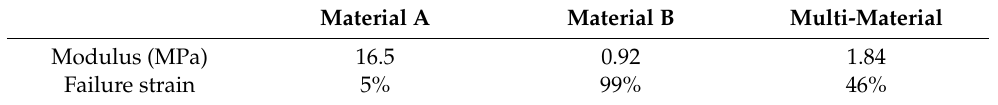
Table 8. Tensile properties of single and multi-material structures [61].